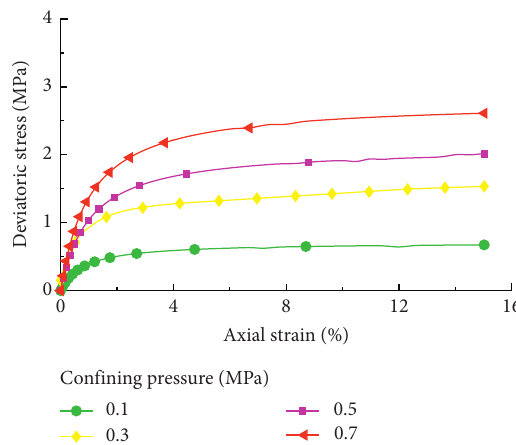
Figure 12: Deviatoric stress-axial strain of fiber-reinforced soil with different confining pressure (fiber length � 12mm; compac- tion degree � 100; fiber content � 0.2%).